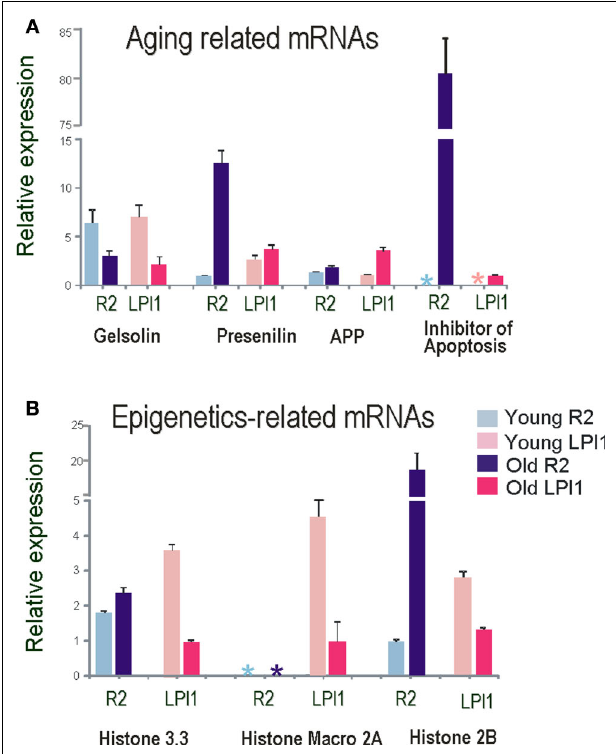
FIGURE 8 | Single cell Q-RT-PCR analysis of differentially expressed transcripts as a function of aging in identifi ed neurons. Several transcripts differentially expressed on the microarrays were validated by Quantitative RT PCR. All data were normalized to 18S RNA and all tests were performed in quadruplicate and statistically analyzed (see text and Materials and Methods for details). (A) Relative expression of Gelsolin and Alzheimer’s disease related transcripts in identifi ed cholinergic neurons R2 (blue bars) and LPl1 (red bars). Asterisks indicate no detectable levels of expression in a given cell (R2 and LPl1) for inhibitors of apoptosis in young animals. These results were validated by reported values obtained from microarray tests. (B) Relative expression of different histone variants in identifi ed cholinergic neurons R2 (blue bars) and LPl1 (red bars). Asterisks indicate no detectable level of expression in macro 2A histone in R2 neurons isolated from both young and old